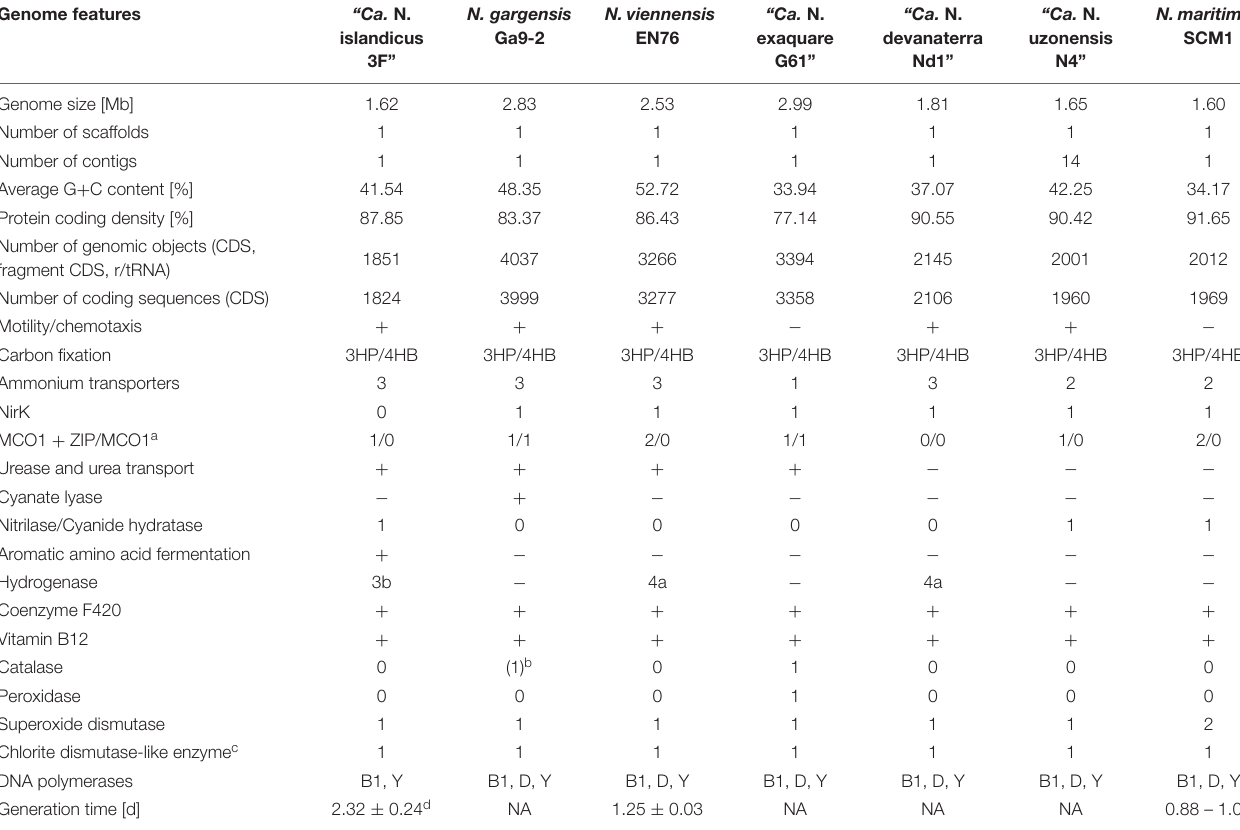
TABLE 1 | Genome features and growth rates of “ Candidatus N. islandicus” and of selected reference ammonia-oxidizing archaea (AOA). Genome